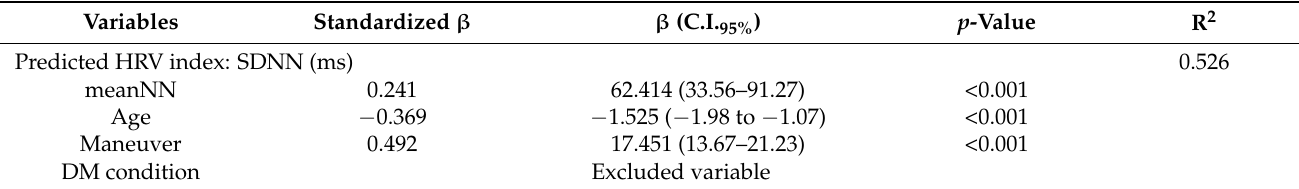
Table 5. Linear stepwise multiple regression analysis with predicted HRV indices and, as independent variables, the meanNN, maneuver, diabetes mellitus (DM) condition, and age. The regression models were applied on the combined samples from supine position and rhythmic breathing in both groups (healthy and